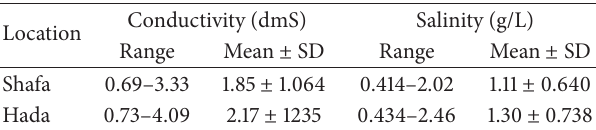
Table 4: Conductivity and salinity of soil collected from Shafa and Hada